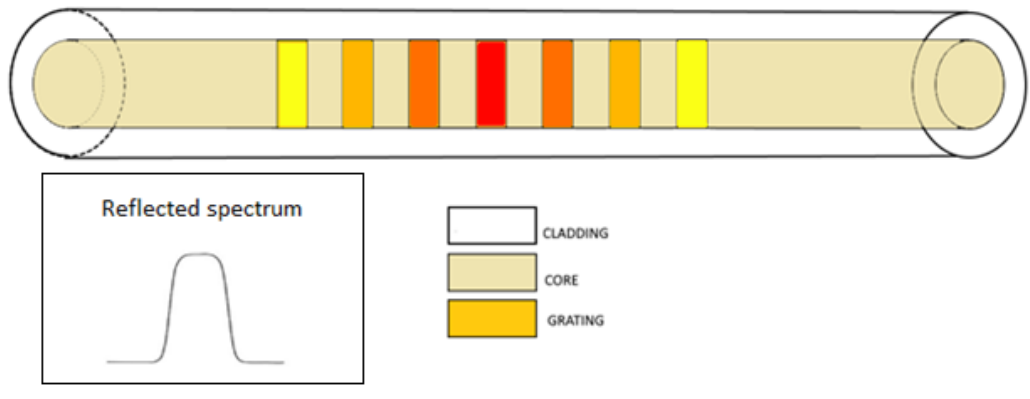
Figure 6. Apodized FBG. Inset: reflected spectrum.